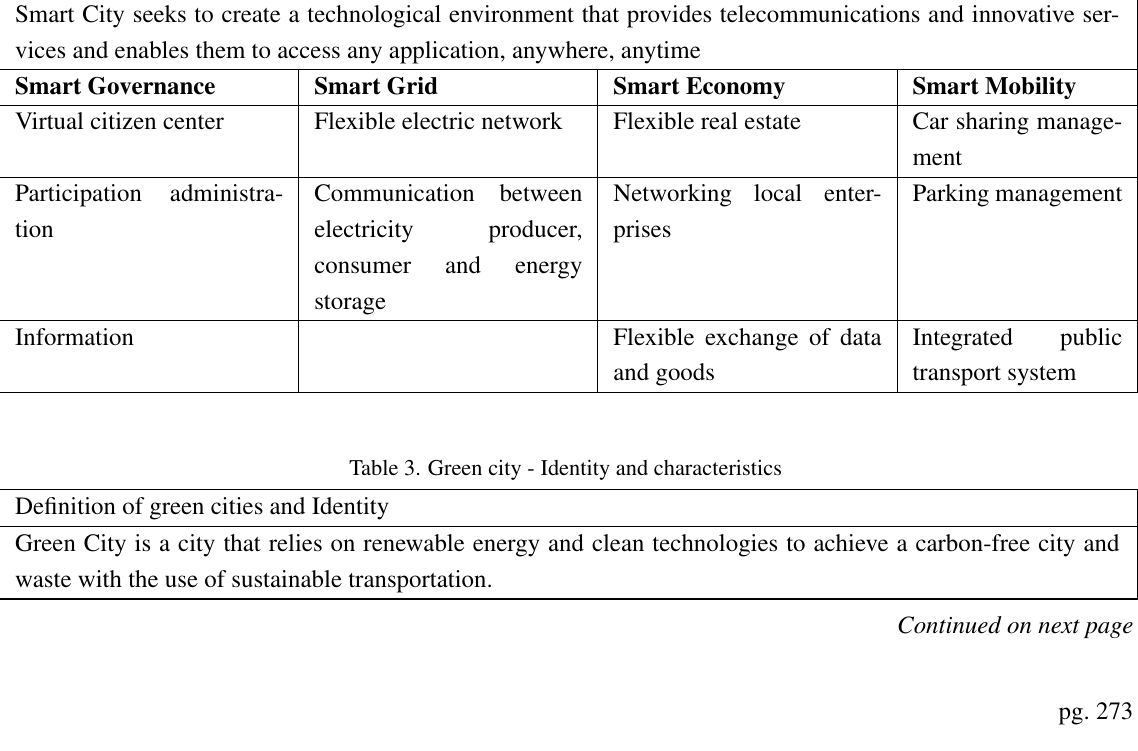
Table 2. Smart city - Identity and characteristics